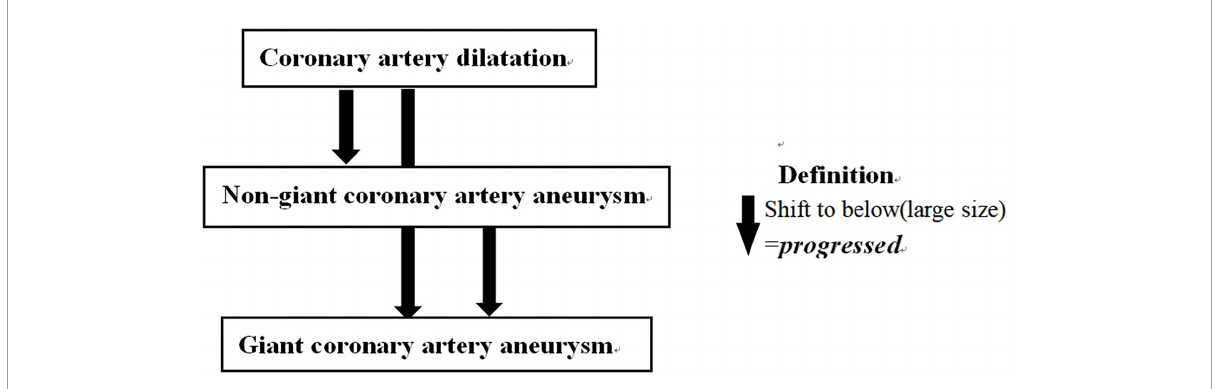
FIGURE2 Definition of CALs outcomes. CALs outcomes were classified as CALs changes from the time that CALs were detected to 1 month after KD onset in two categories: progressed and no progressed. CALs, coronary artery lesions; KD, Kawasaki